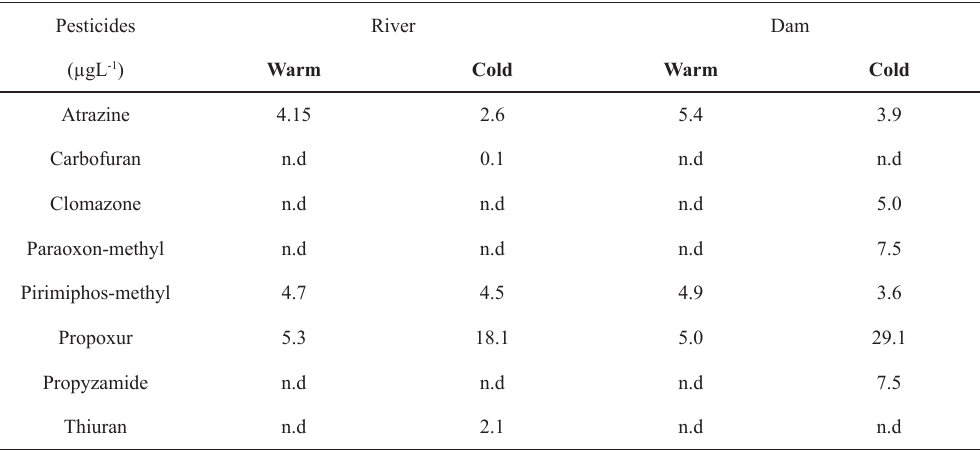
Table 2. Means of multiresidue of pesticides (µg L -1 ) found in the sites and seasons during studied period. Limit of detection: 0.037µgL -1 . Limit of quantification: 0.12µgL -1 . (n.d: not